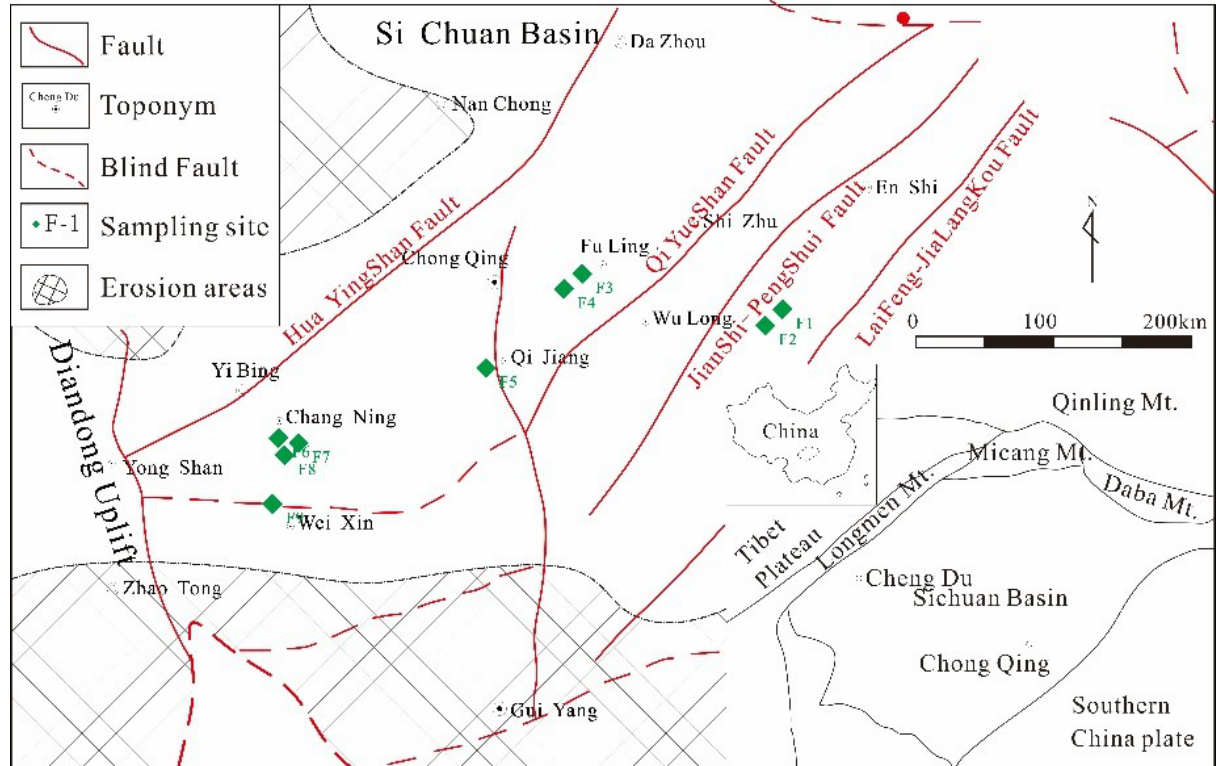
Figure 1: Distribution of sampling points of organic-rich